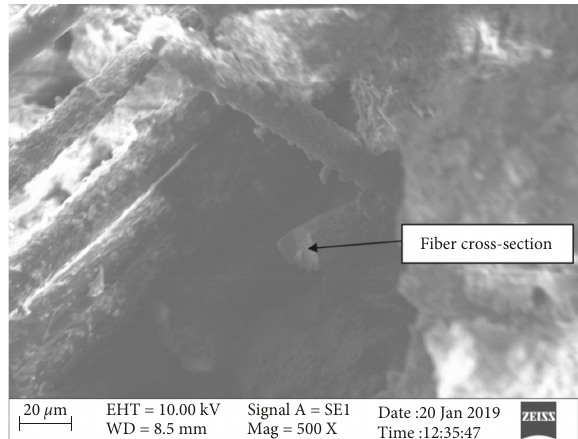
Figure 24: The basalt fiber section at the failure of water stabilized recycled waste brick mixture.